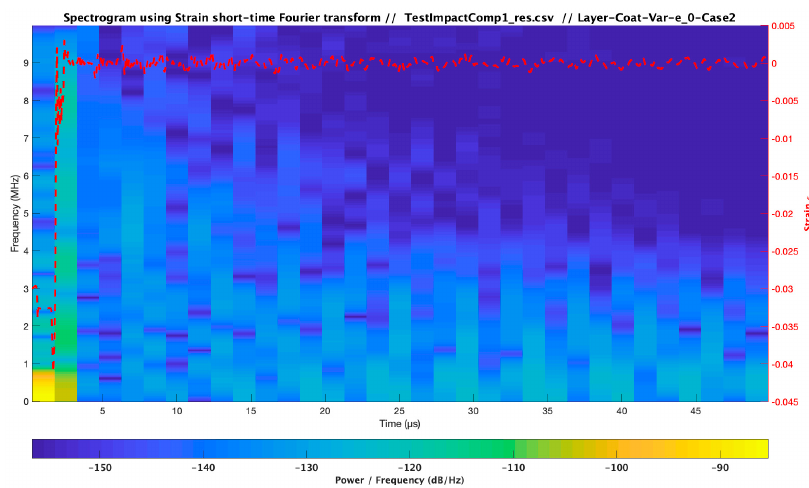
Figure 19. Spectrogram for strain evolution at the coating surface for the Reference multilayer configuration. Material models analysis for Kelvin-Voight consideration.